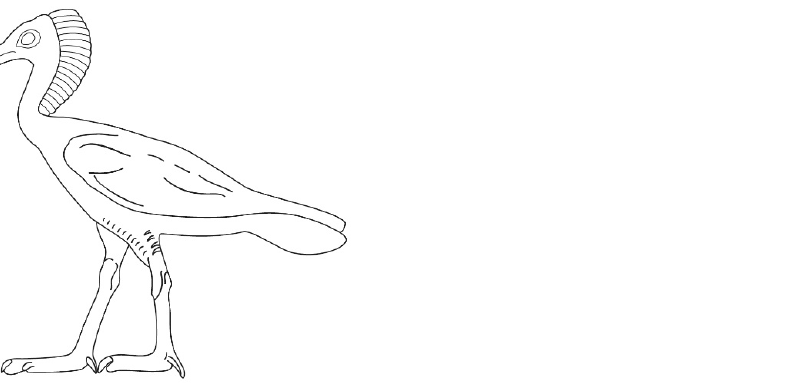
Figure 2. The hieroglyphic Akh-sign from the tomb of Akhethotep (ca. 2400 BCE). Drawing by Lucie Vařeková.